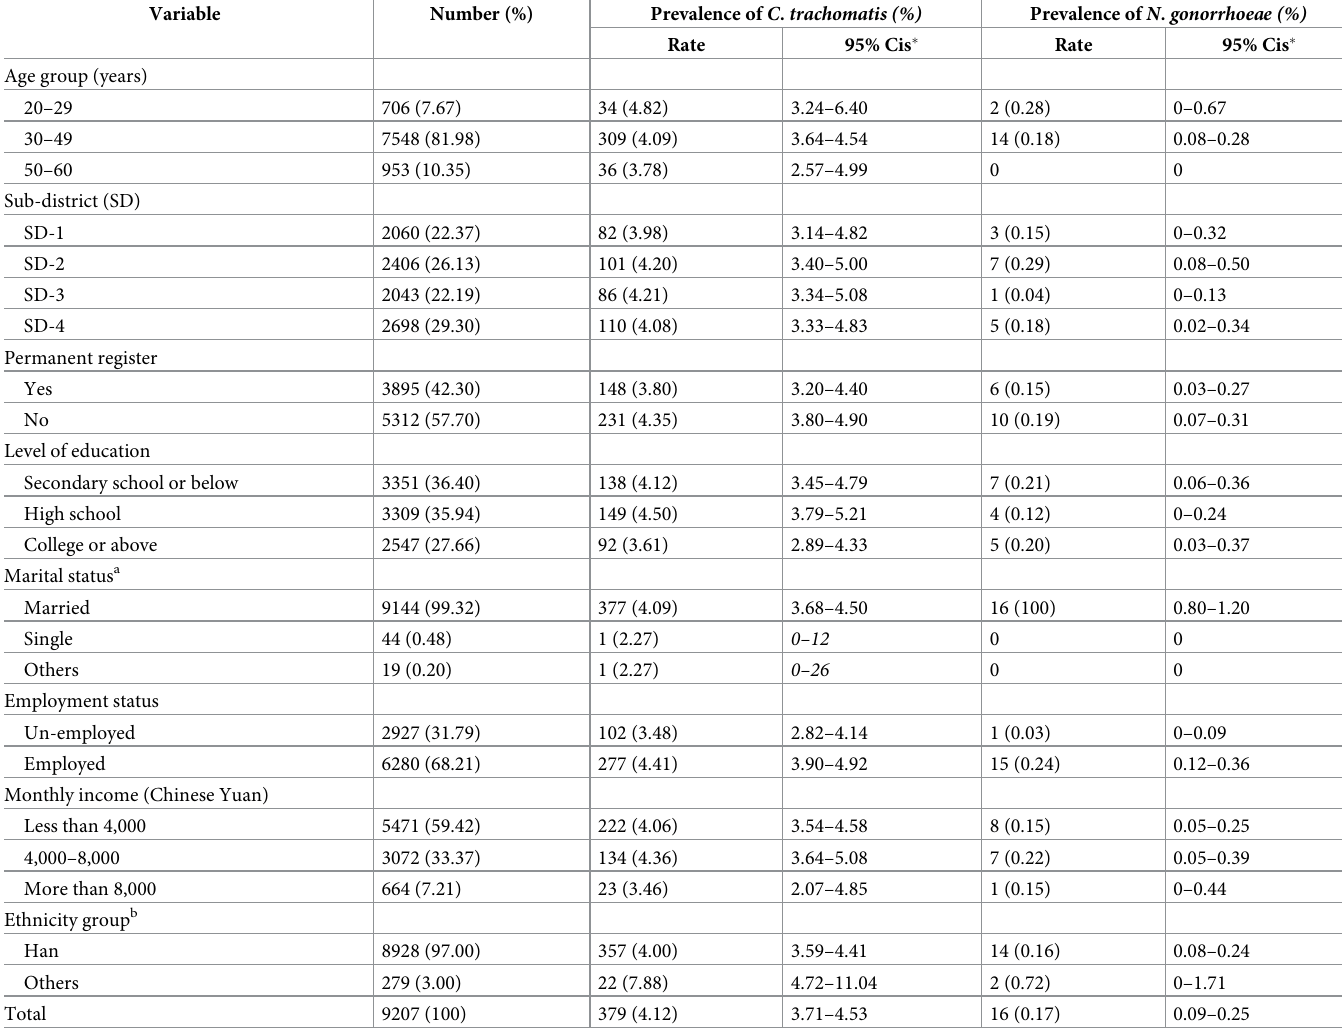
Table 1. Prevalences of C . trachomatis and N . gonorrhoeae by socio-demographic